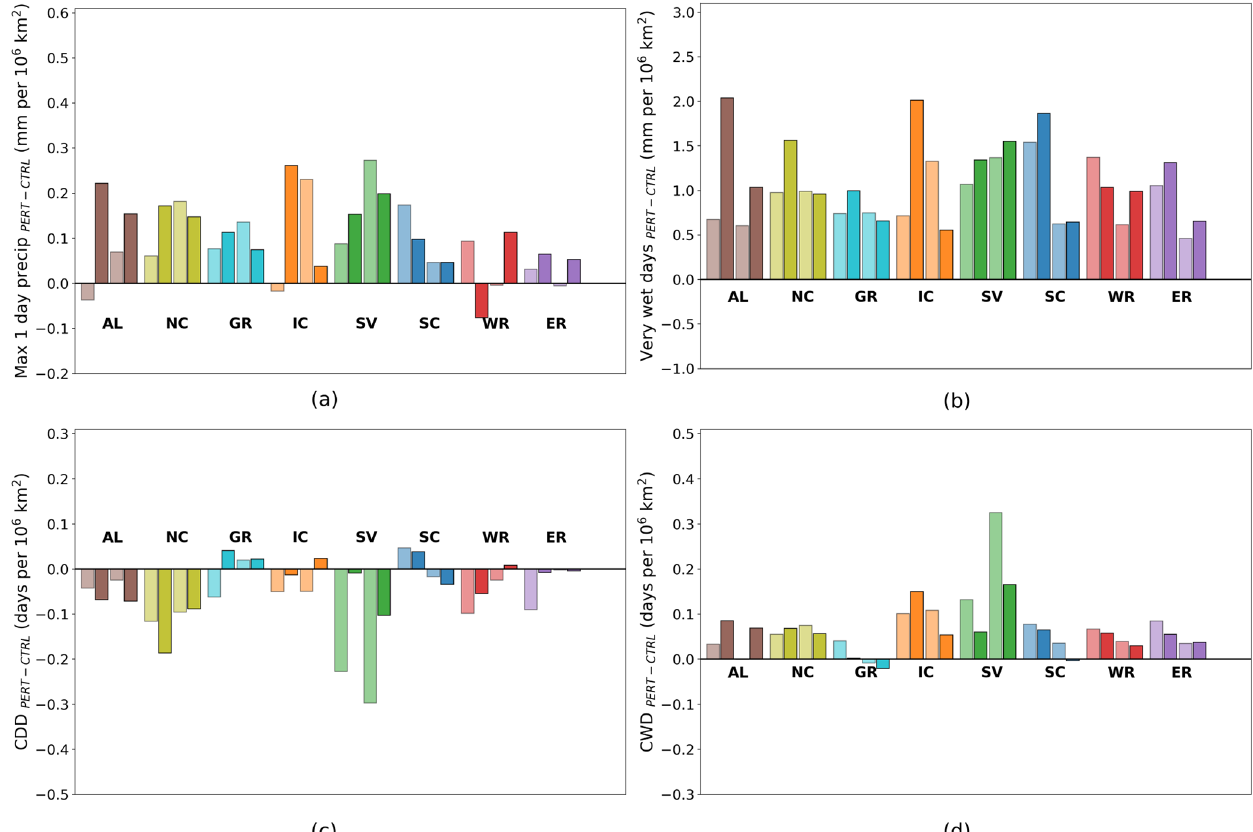
Figure 11. Ensemble mean changes (PERT − CTRL) per month in summer (JAS) in maximum 1d precipitation (a) , very wet days (b) , consecutive dry days (c) and consecutive wet days (d) scaled by the amount of sea ice extent loss for the eight regions (Fig. 2) for ECMWF- LR (left light bar), ECMWF-HR (left dark bar), CNRM-LR (right light bar) and CNRM-HR (right dark bar). The response is scaled by the amount of the summer Arctic sea ice